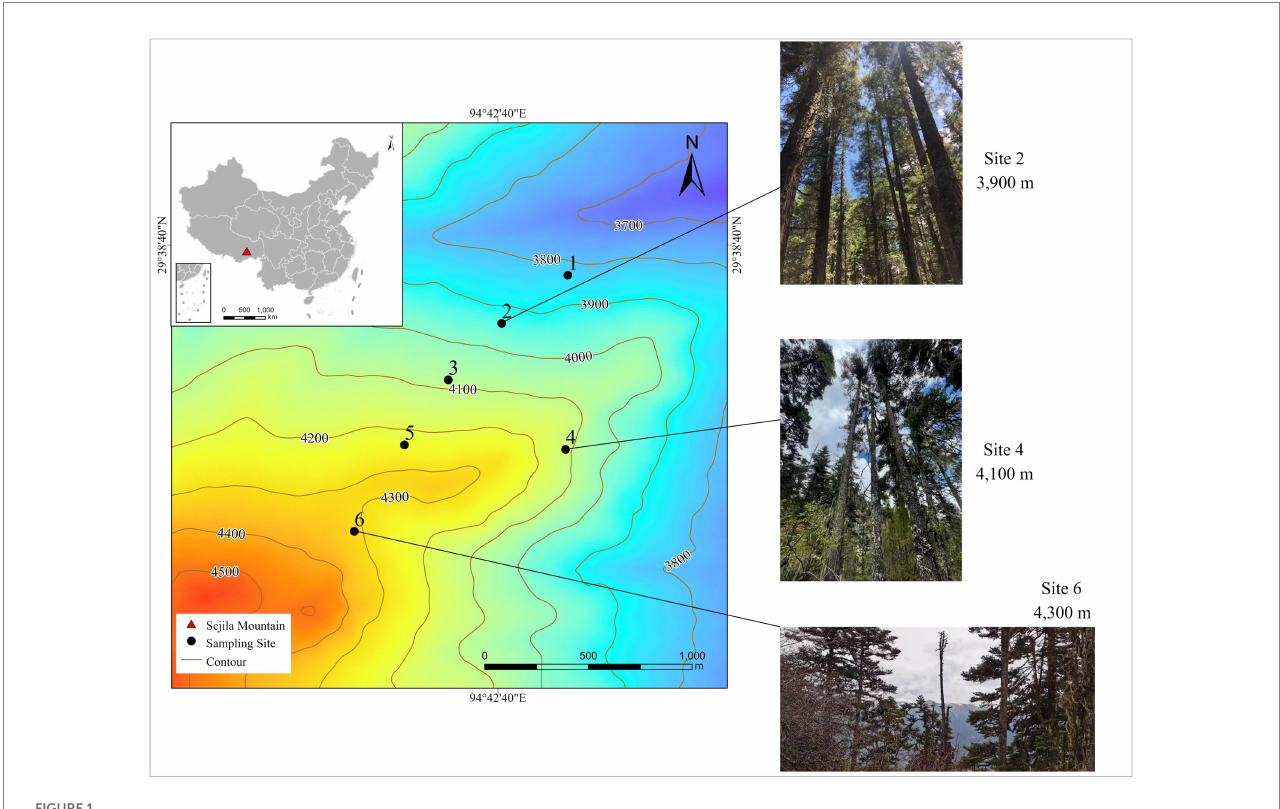
FIGURE 1 Identification map of sampling point in Sejila Mountain.